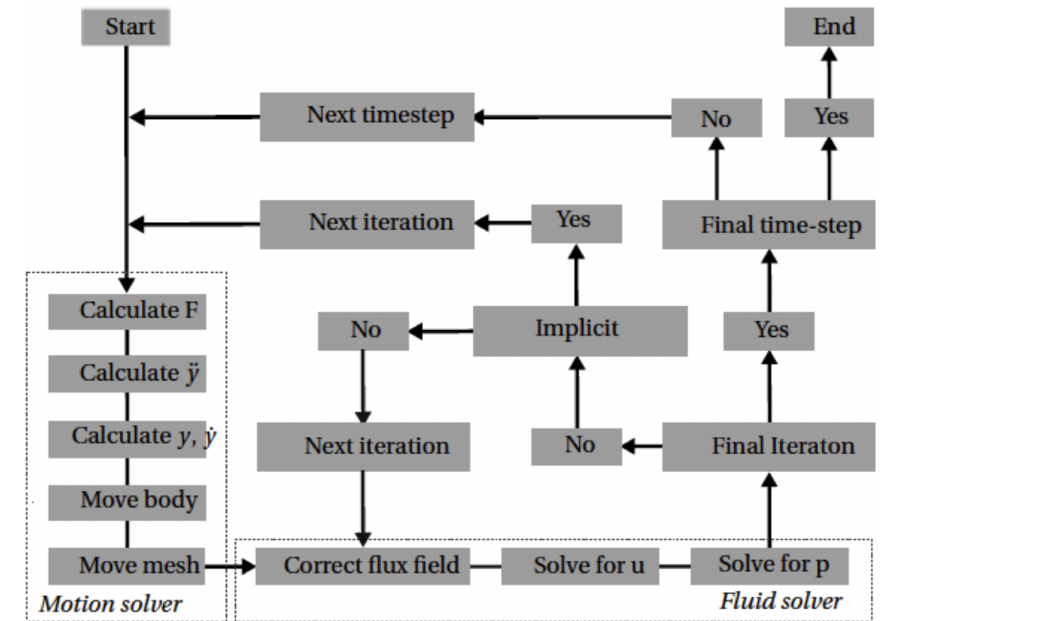
Figure 1. Sketch of the weakly (explicit) and strongly (implicit) coupled algorithms between structure and fluid solvers. Figure taken from Derksen (2019).